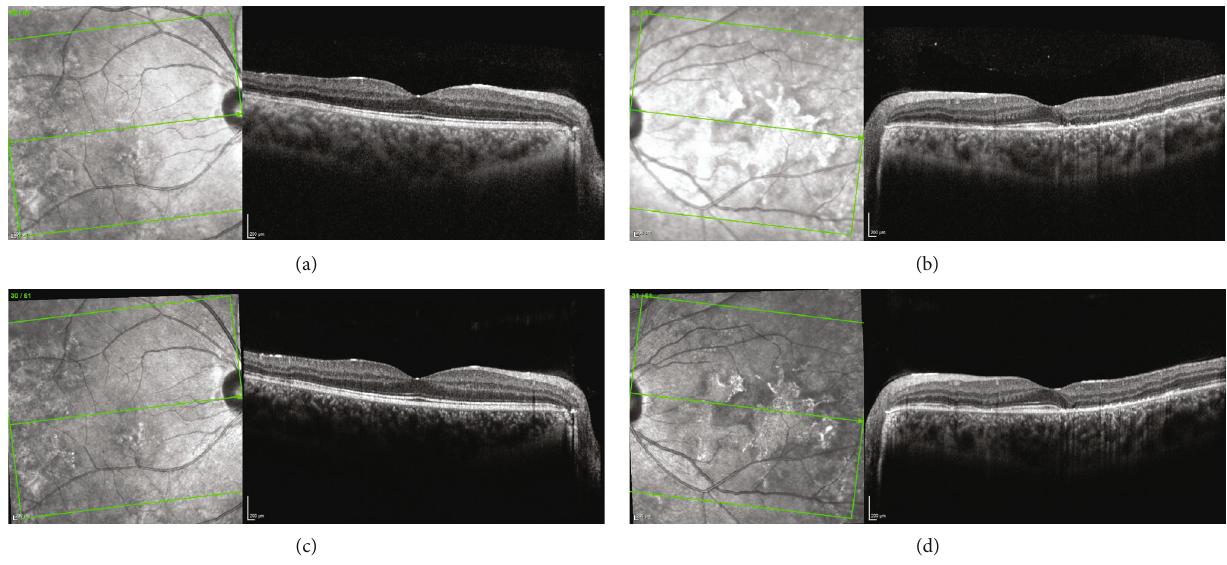
Figure 2: Optical coherence tomography. Optical coherence tomography of the (a) right and (b) left eyes on initial visit. The macular lesions are associated with outer retinal irregularities in both eyes. After initiating treatment, the placoid lesions in the (c) right and (d) left eyes did not progress or improve 8 weeks after the initial